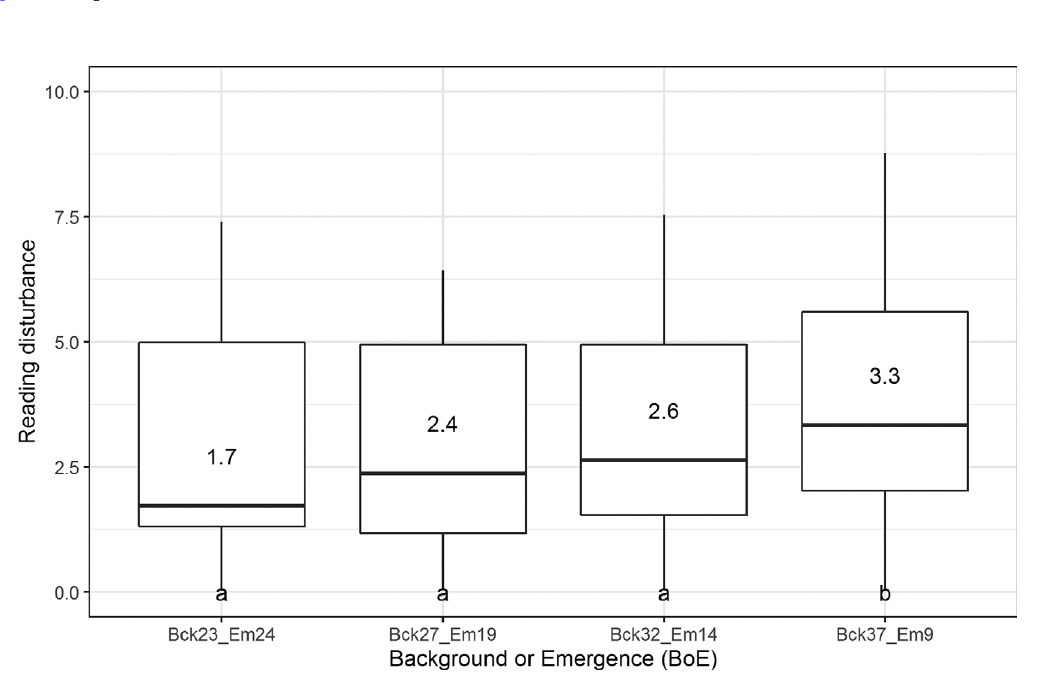
Figure 7. Reading disturbance according to the (BoE) factor only for the group of noise sensitive participants. Labels correspond to median values for each distribution. The two groups a and b, representing signi fi cant different distributions, are extracted from the Nemenyi post-hoc